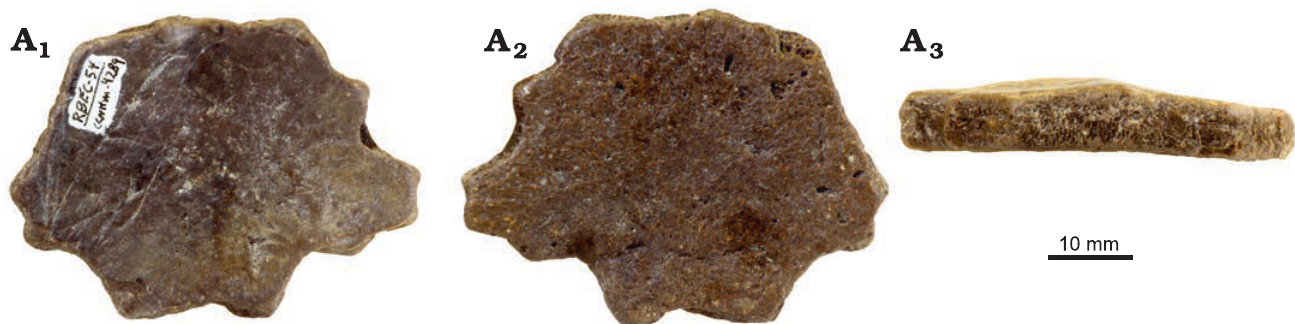
Fig. 4. Ossicle of leatherback turtle cf. Egyptemys sp. (CCNHM 4289) from Oligocene of South Carolina, USA, in dorsal (A 1 ), visceral (A 2 ), and sutural (A 3 )